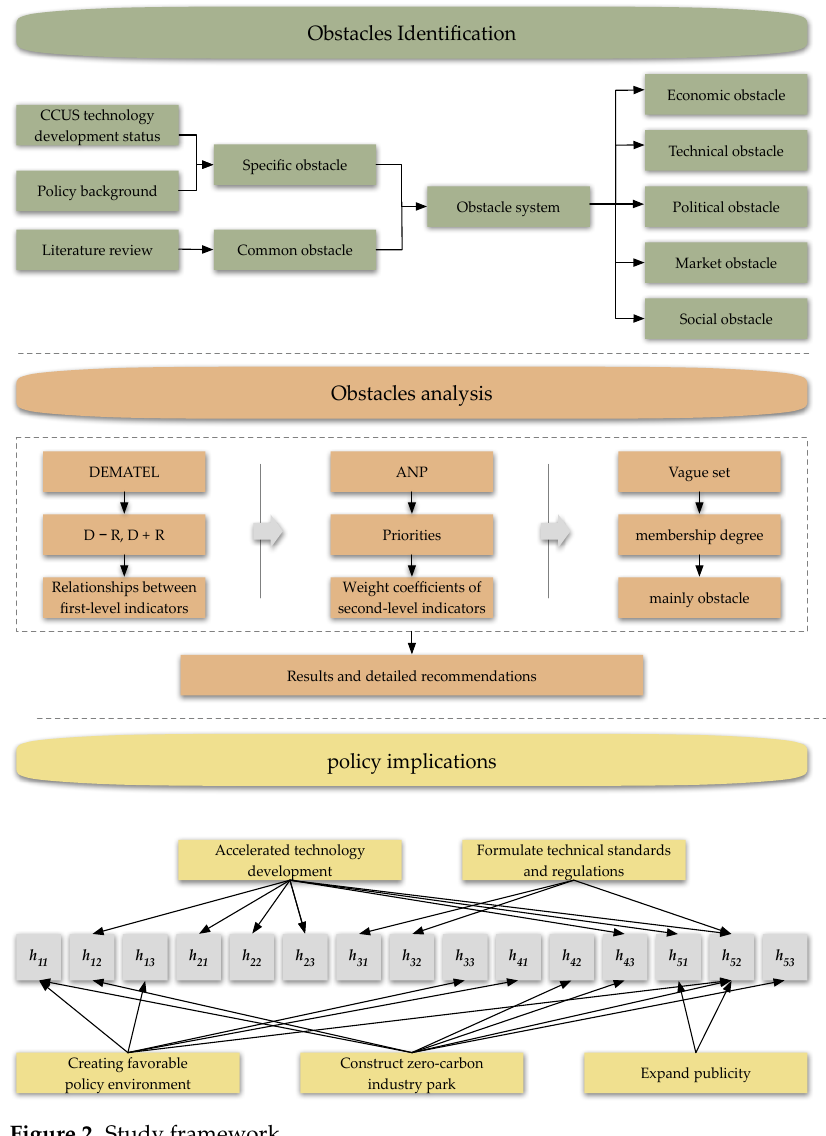
Figure 2. Study framework.